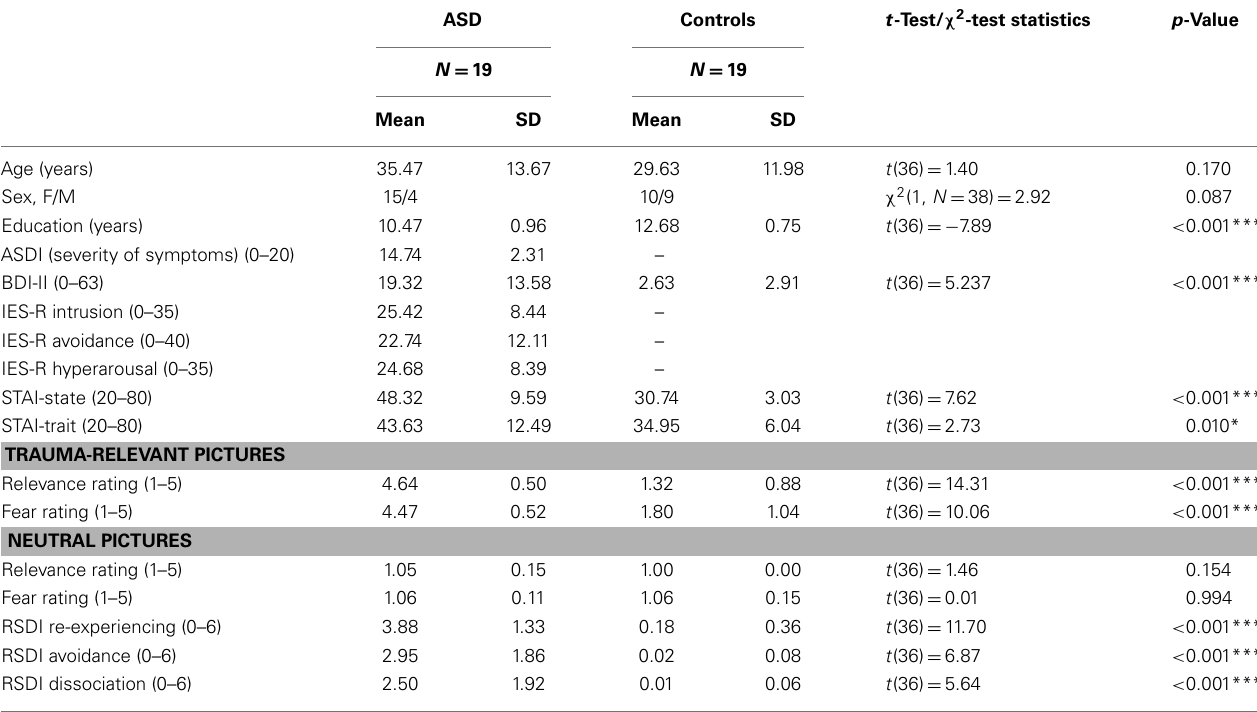
Table 1 | Demographic and clinical characteristics of patients with acute stress disorder (ASD) and controls . ASD Controls